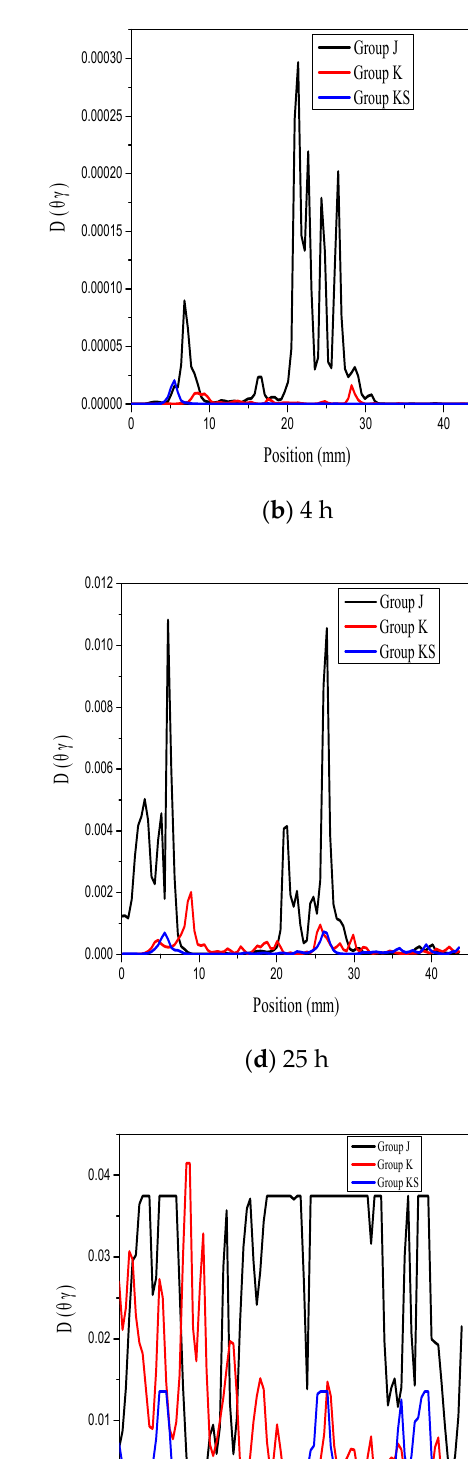
Figure 6. Comparison of the exponential 𝐷(𝜃𝛾) at different time intervals.